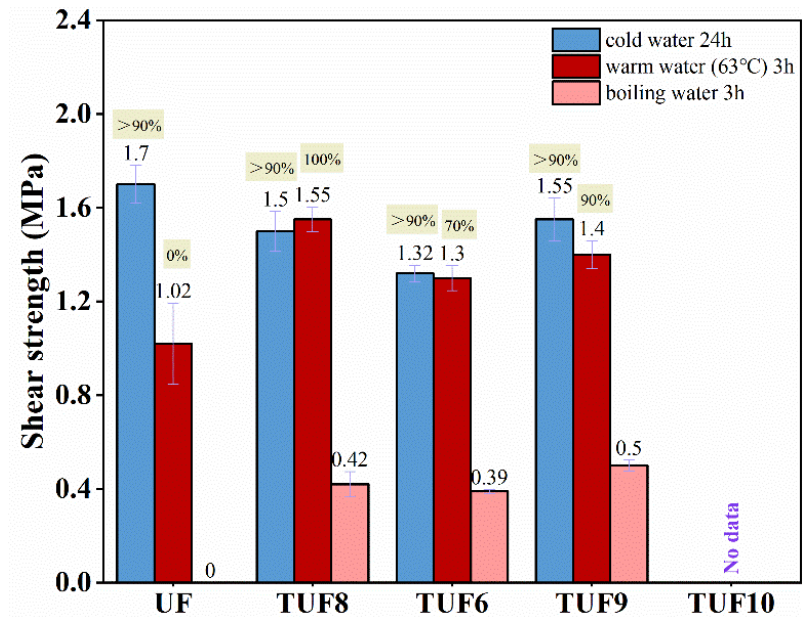
Figure 8. Shear strength of plywood specimens bonded with resins prepared with different tannin additions (the highlight indicates the wood failure rate).